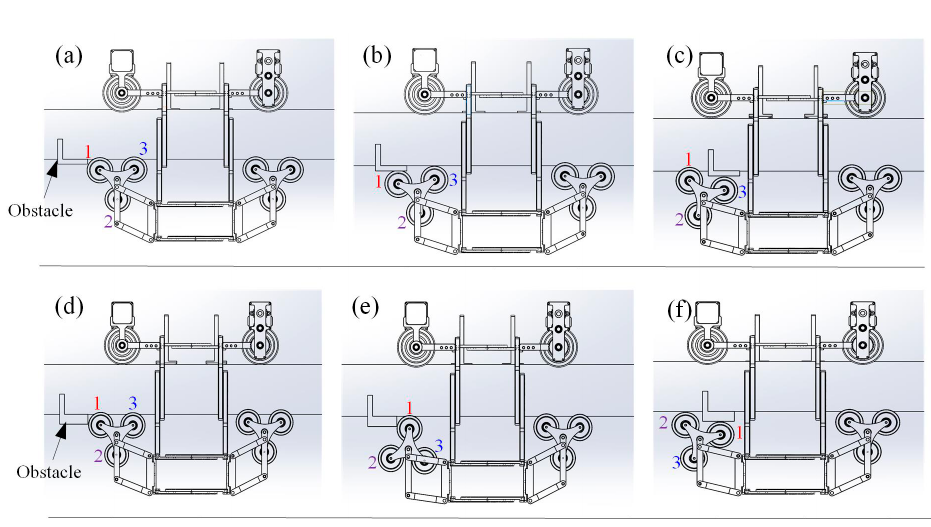
Figure 6. Obstacle-surmounting modality of pipeline-climbing: ( a – c ) Surmounting low obstacle; ( d – f ) Surmounting high